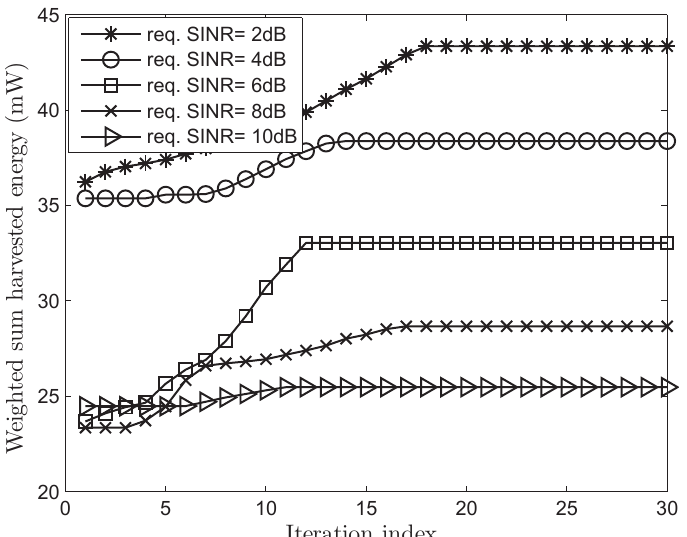
Figure 2. The iteration behavior of the proposed PSO-based algorithm when the required signal-to-interference-plus-noise ratios (SINRs) are given as 2, 4, 6, 8, and 10 dB, respectively and a random perfect CSI is considered.